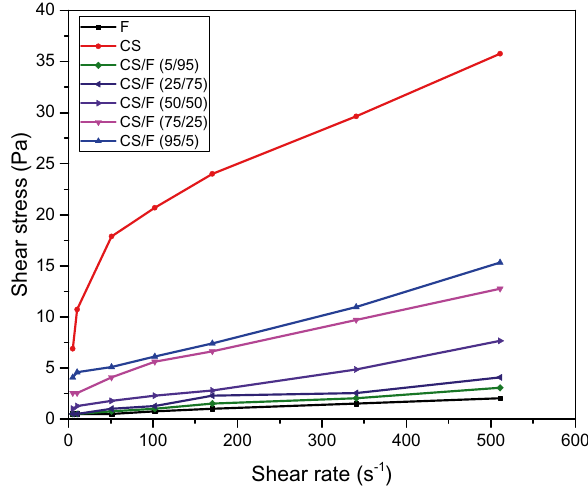
Fig. 5 Flow curve for the cement slurry (CS), the flushing fluid (for- mulation F) and their mixtures